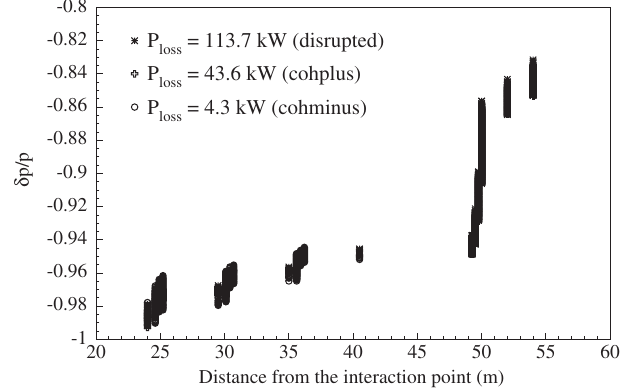
FIG. 20. Relative energy spread of the lost particles as a function of the position of loss in the CLIC post-collision line, obtained when tracking the charged beams. The wrong-sign charged particles absorbed in their dump are not